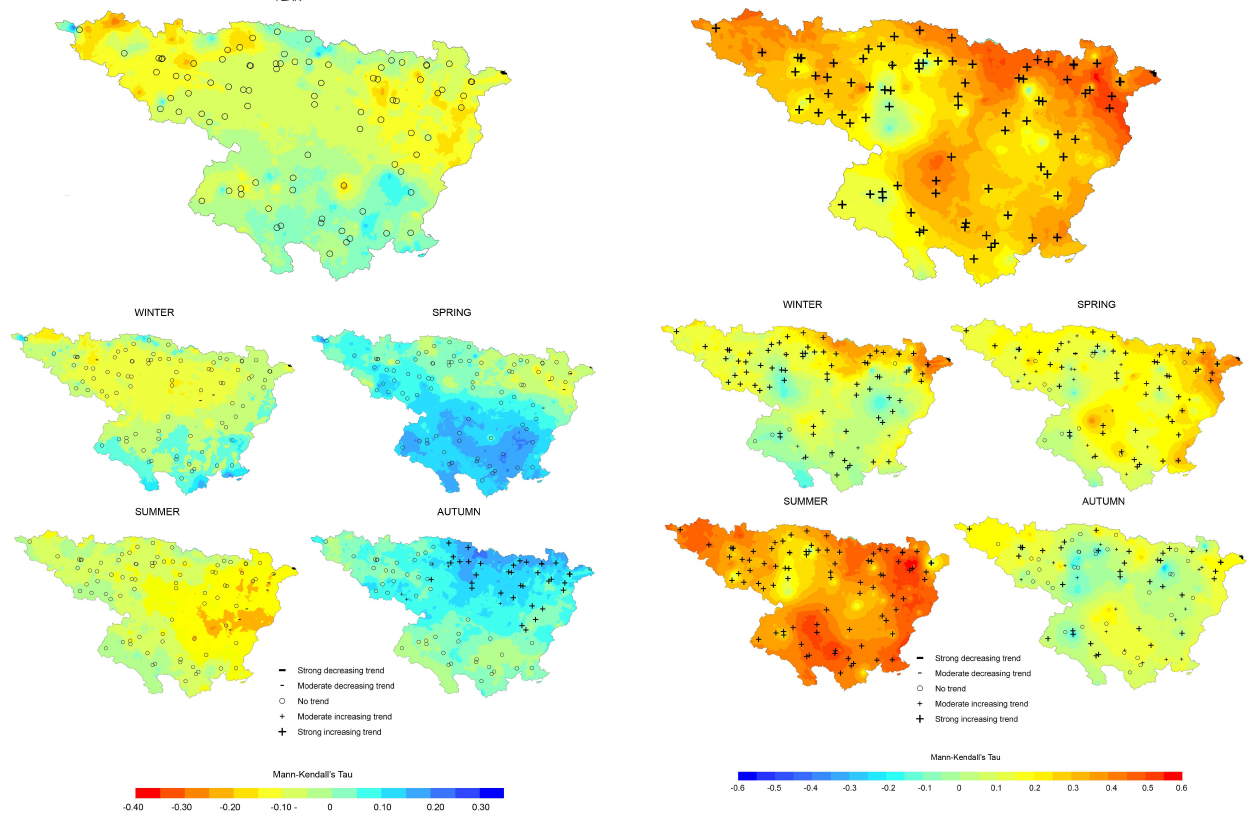
Fig. 3. Trend of annual and seasonal temperature for the Ebro basin during the studied period (1950–2006). The color scale shows the Mann-Kendall tau coefficients for each 1km 2 cell. The symbols show the sign of the trend for the average temperature in the area drained at each of the 88 gauging